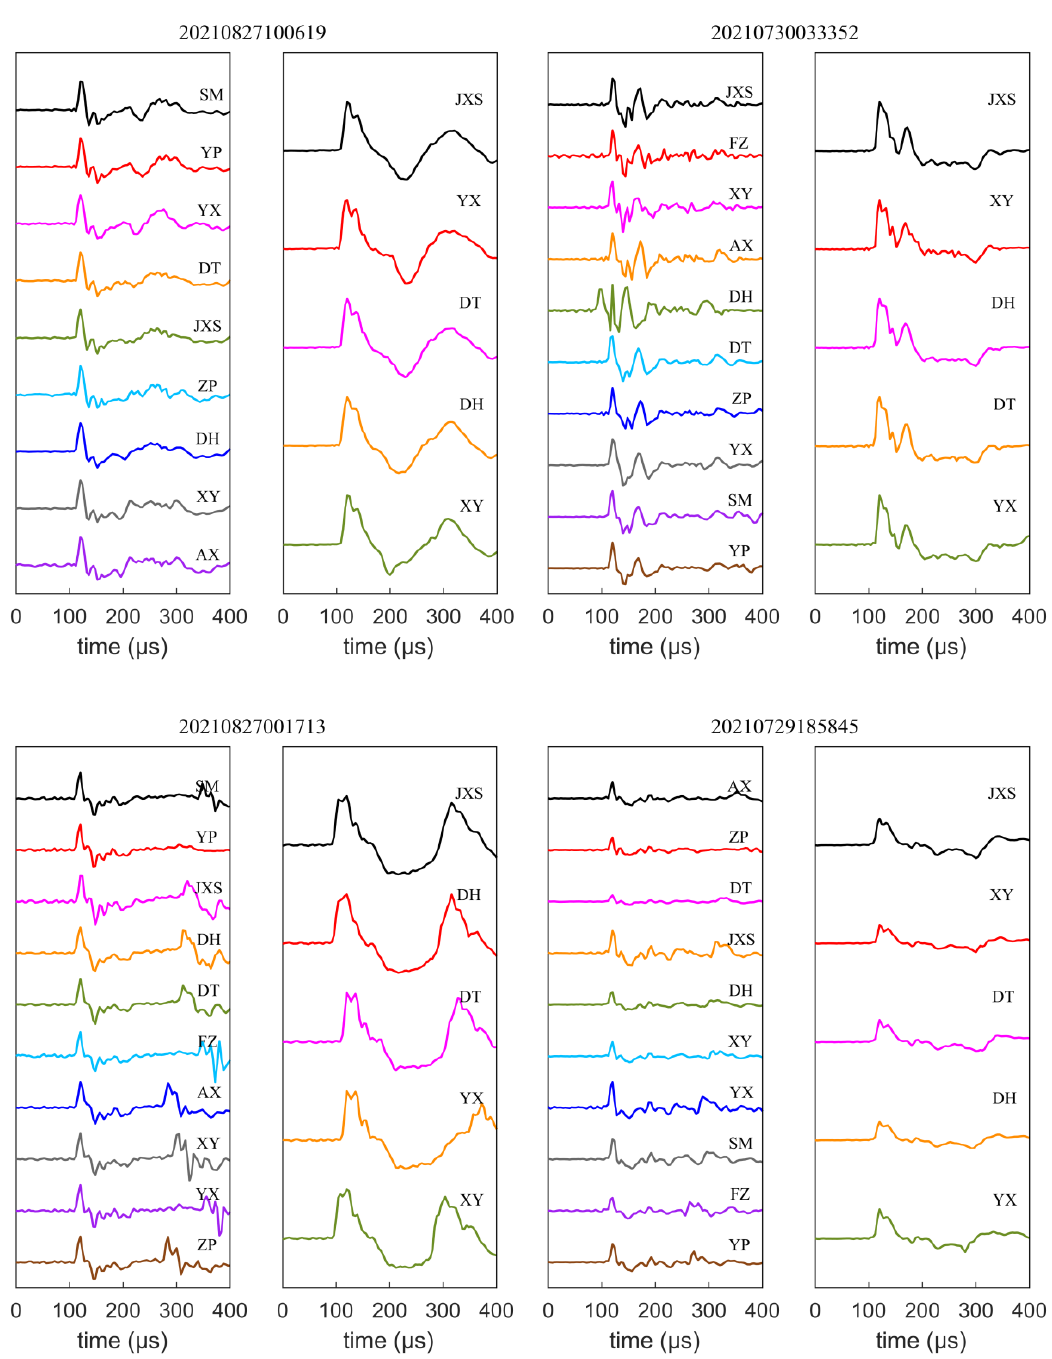
Figure 3. The recorded synchronous waveforms of lightning return strokes corresponding to six cases in Figure 2. The left part in subgraph shows the magnetic field waveform. The right part is the electric field waveform of the same case.